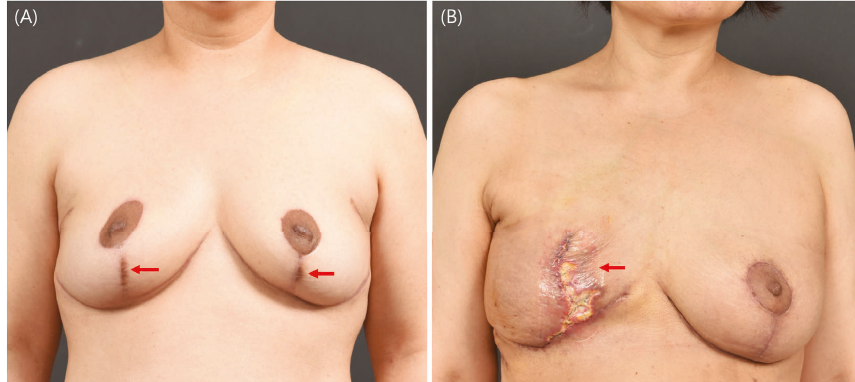
Figure 7: Postoperative complications. (a) Remnant areolar tissue is observed on the postoperative vertical scar of both inferior poles. (b) Skin-sparing mastectomy and extended latissimus dorsi flap reconstruction resulted in skin flap necrosis with a poor aesthetic outcome due to insufficient blood supply from the subdermal plexus